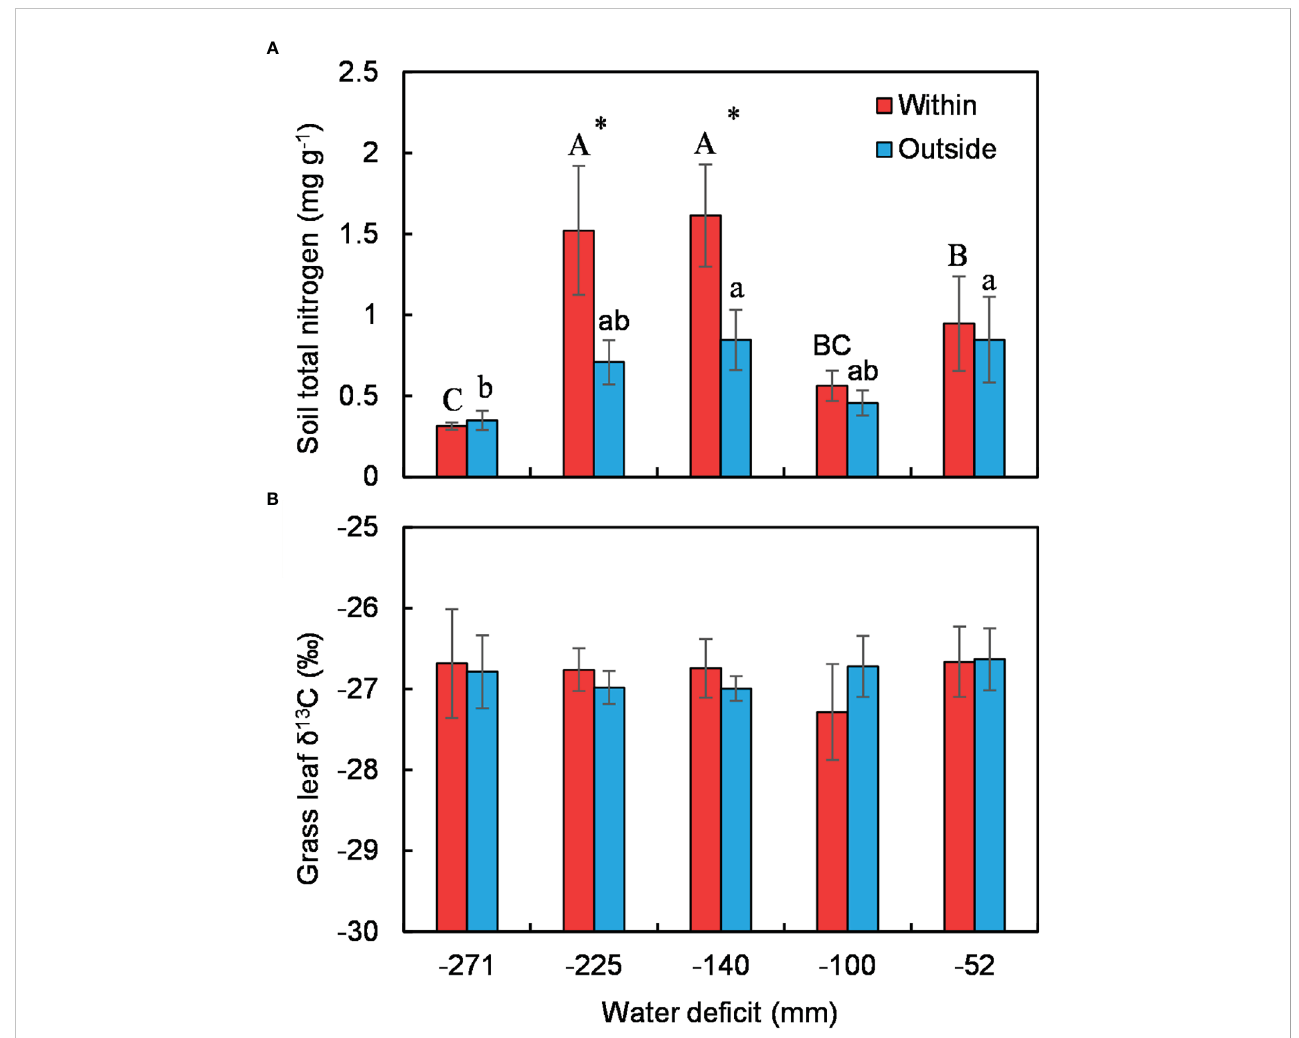
FIGURE 4 Variations in soil total nitrogen (A) and grass leaf d 13 C (B) under Caragana versicolor and in open areas along the water de fi cit gradient in drylands of Tibetan Plateau. Different letters indicate signi fi cant differences in soil total N or d 13 C between sites; asterisks show signi fi cant differences between the shrub understory and open